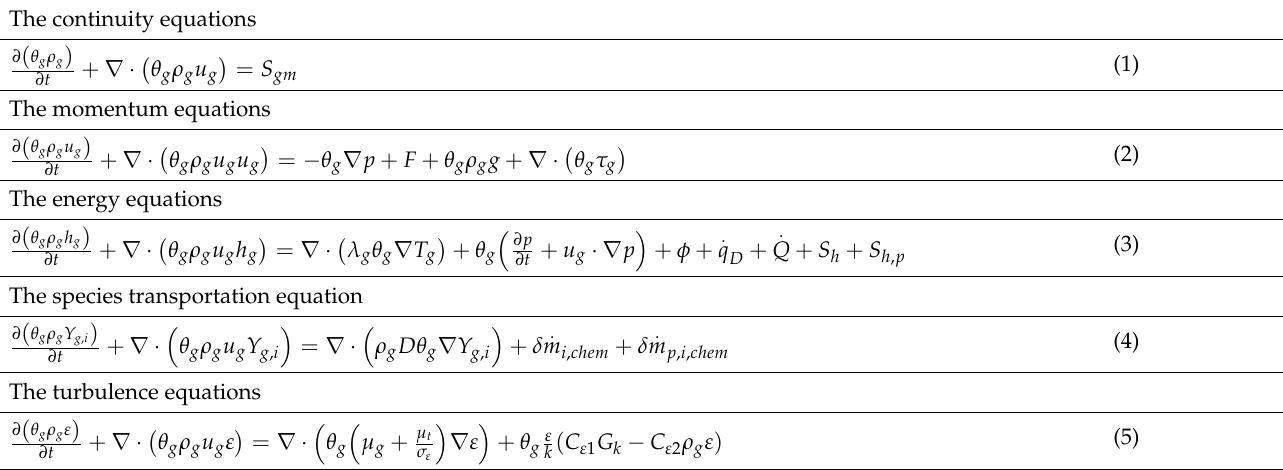
Table 1. Governing equations for gas phase.